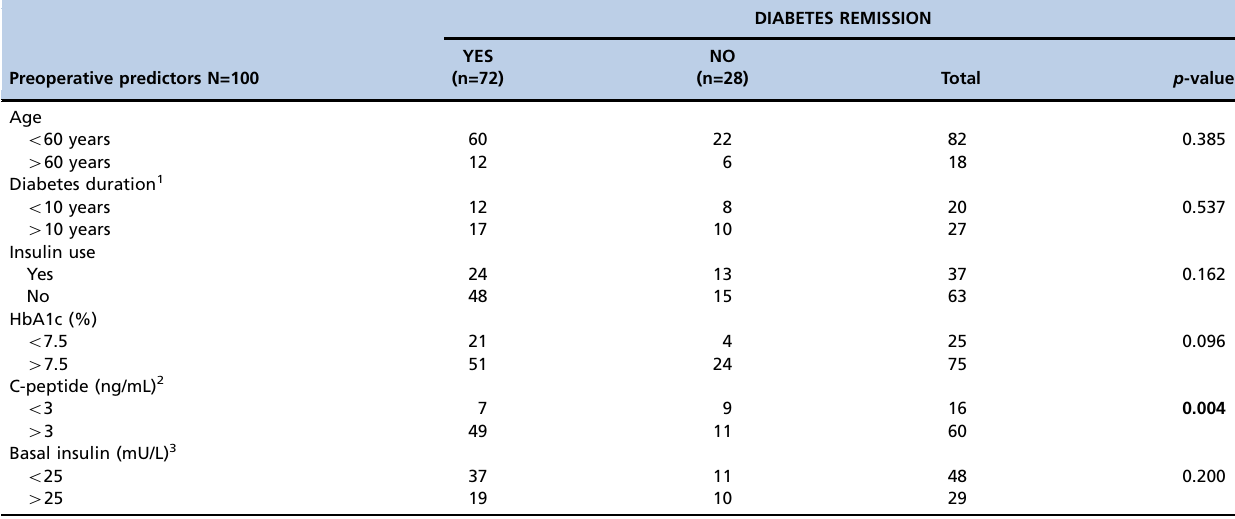
Table 1 - Preoperative predictors of diabetes remission at 3 years after Roux-en-Y gastric bypass in patients with severe obesity and type 2 diabetes mellitus (retrospective phase). Diabetes remission was defined as a fasting glycemia o 126 md/dL and/or a glycated hemoglobin (HbA1c) level o 6.5%.